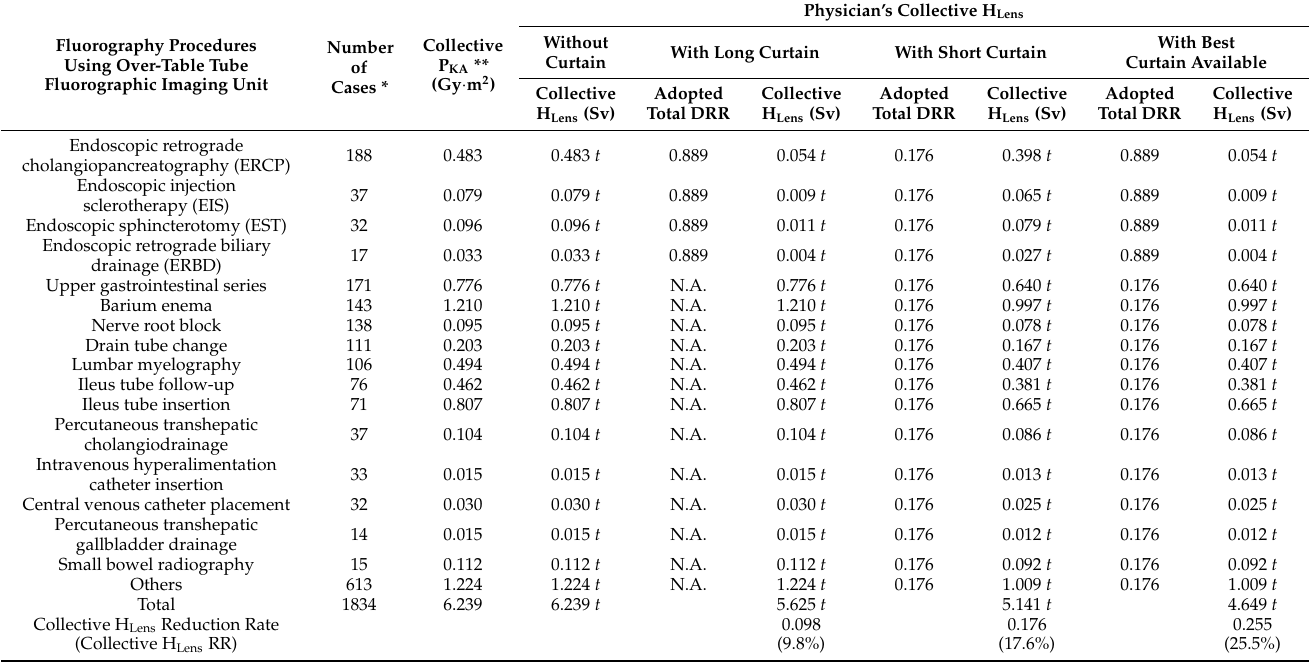
Table 2. Reduction rate in the collective equivalent dose for the lens of the physician’s eye with the long curtain and the short